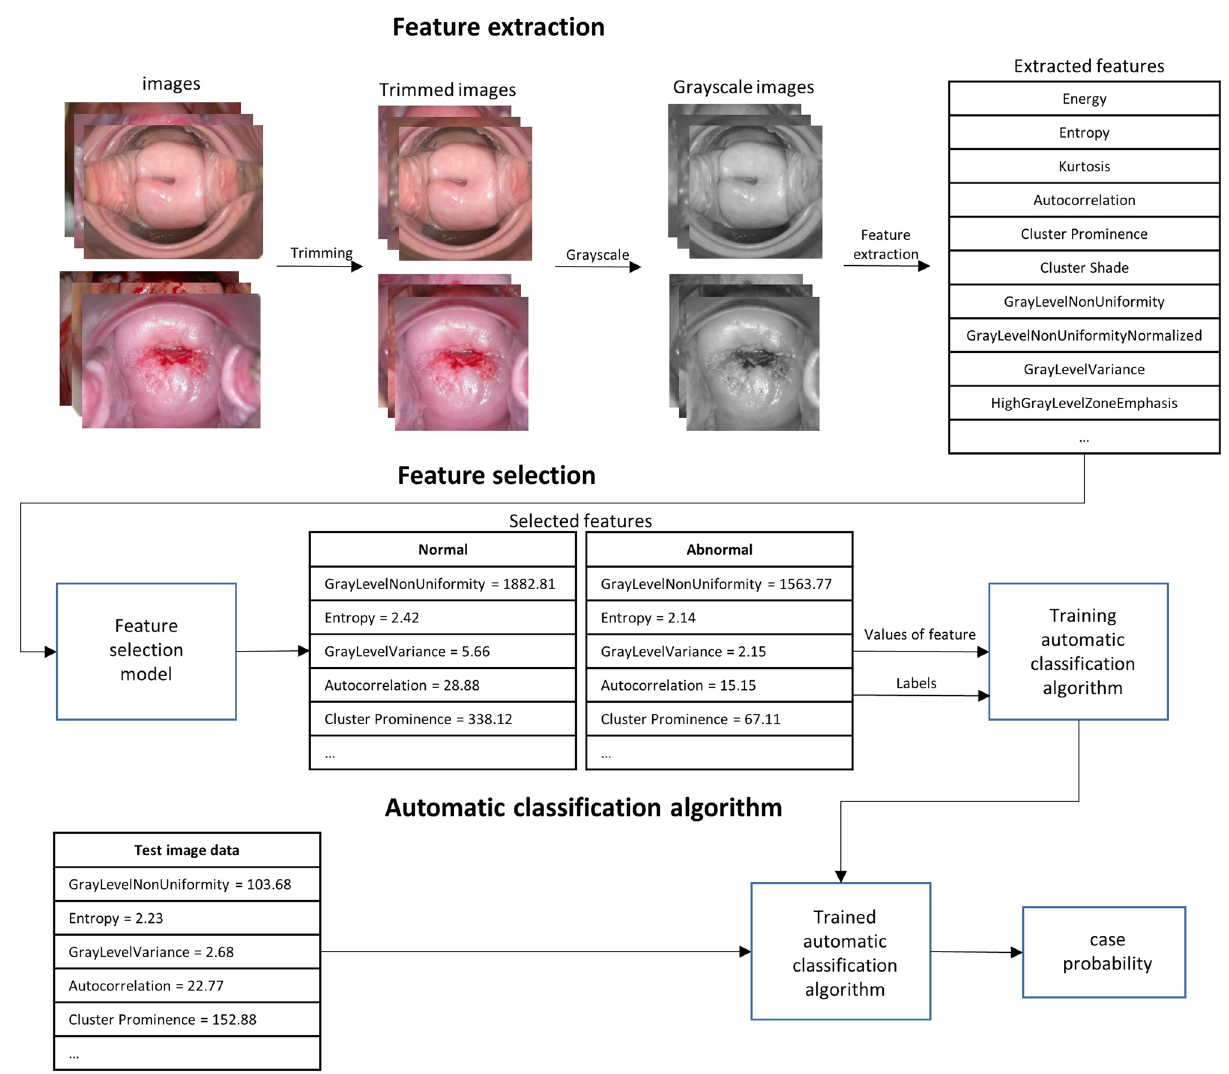
Figure 1. ML model training process for cervical cancer classification. The trimmed and grayscaled input data, negative and positive groups, are used to extract radiomics features. After the feature selection process, 10 features were selected for cervical cancer classification. The trained model then classified the test images and produced